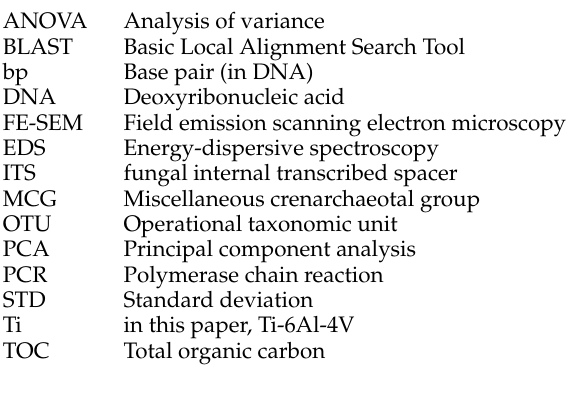
Figure S1: EDS spectra for coupons. (a) 254SMO chlorinated; (b) Ti alloy chlorinated; (c) 254SMO non-chlorinated system; (e) Ti alloy non-chlorinated system. Figure S2: SEM images. (a) Surface; (b) cross-section; (c–e) EDS spectra for particles included in the Inerta160 coating. Figure S3: Temperature ( ˝ C) of the seawater during the experiment. Table S1: Diversity and sequence stats. Table S2: Bacteria, relative abundance and genus level. Table S3: Archaea, relative abundance and genus level. Table S4: Fungi, relative abundance and genus level. Acknowledgments: Finnish Metals and Engineering Competence Cluster (FIMECC) as a part of Breakthrough steels and applications program and Teollisuuden Voima Oyj (TVO) are thanked for funding this work. Pekka Simula and Merja Levy of TVO Olkiluoto Nuclear Power Plant are thanked for their skillful assistance during the sampling and setting up of the experiment. Irina Tsitko is thanked for FE-SEM imaging. FE-SEM imaging made use of the Aalto University Nanomicroscopy Center (Aalto-NMC) premises. Jarkko Metsäjoki is thanked for performing EDS analyses, and Mirva Pyrhönen, Taru Lehtikuusi and Tuomo Kinnunen are thanked for technical